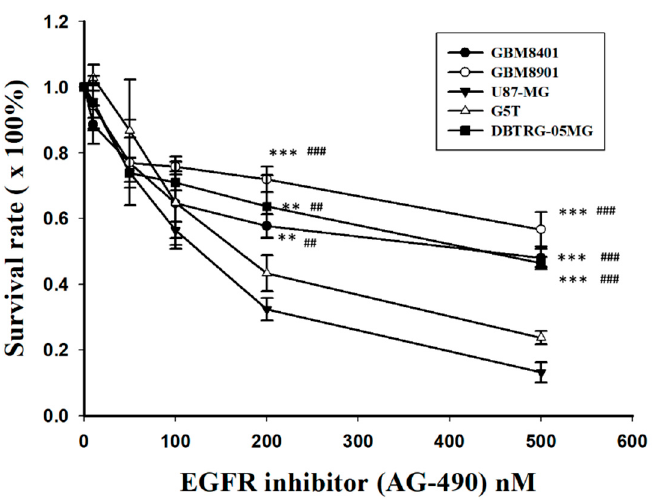
Figure 6. Cell viability analysis after AG490 treatment in all GBM cell lines (n = 4). ** p < 0.01 and *** p < 0.001 compared with U87-MG. ## p < 0.01 and ### p < 0.001 compared with G5T.